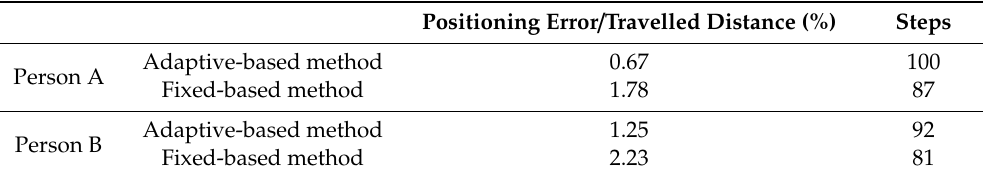
Table 3. The final positioning